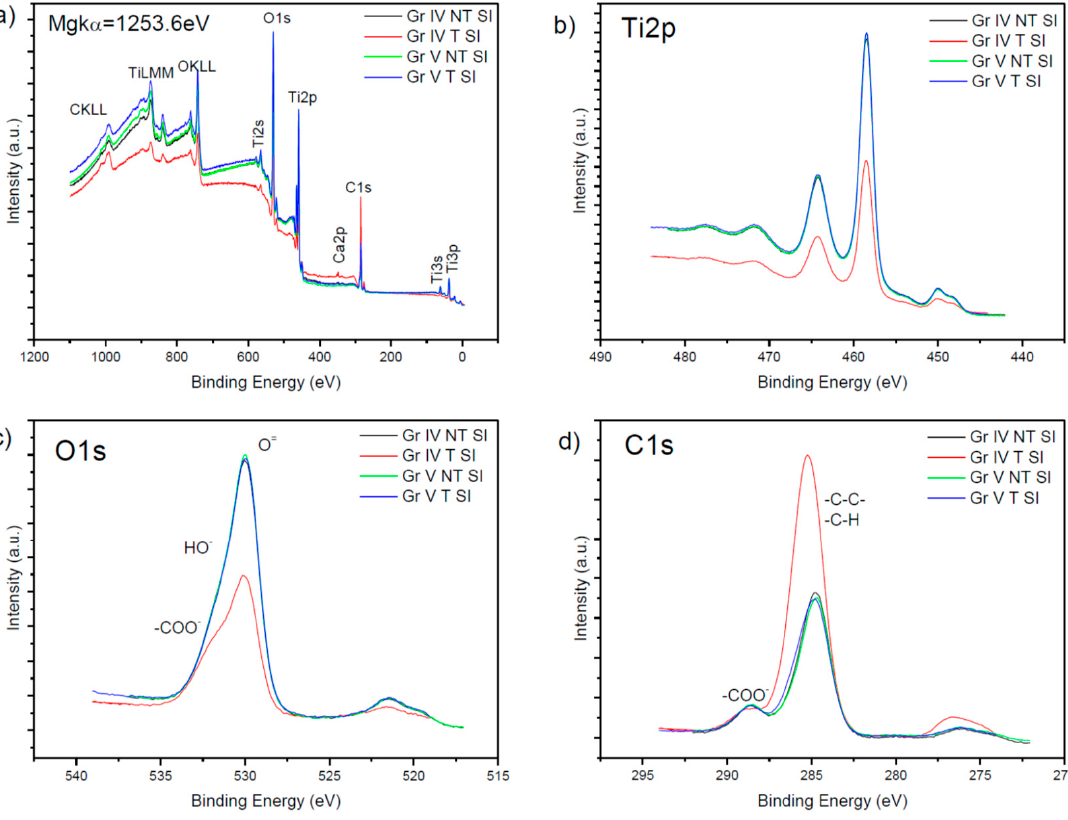
Figure 5. XPS survey spectra, ( a ), Ti 2p XPS spectra ( b ), O1s spectra ( c ), and C 1s spectra ( d ), of untreated TiO 2 grade IV samples (black line), treated (red line), untreated grade V (green line) and treated (blue line) samples. (GR IV: Titanium grade IV; GR V: Titanium grade V; T: SLA treated; NT: SLA non-treated; SI: Treated with TiO 2 film).